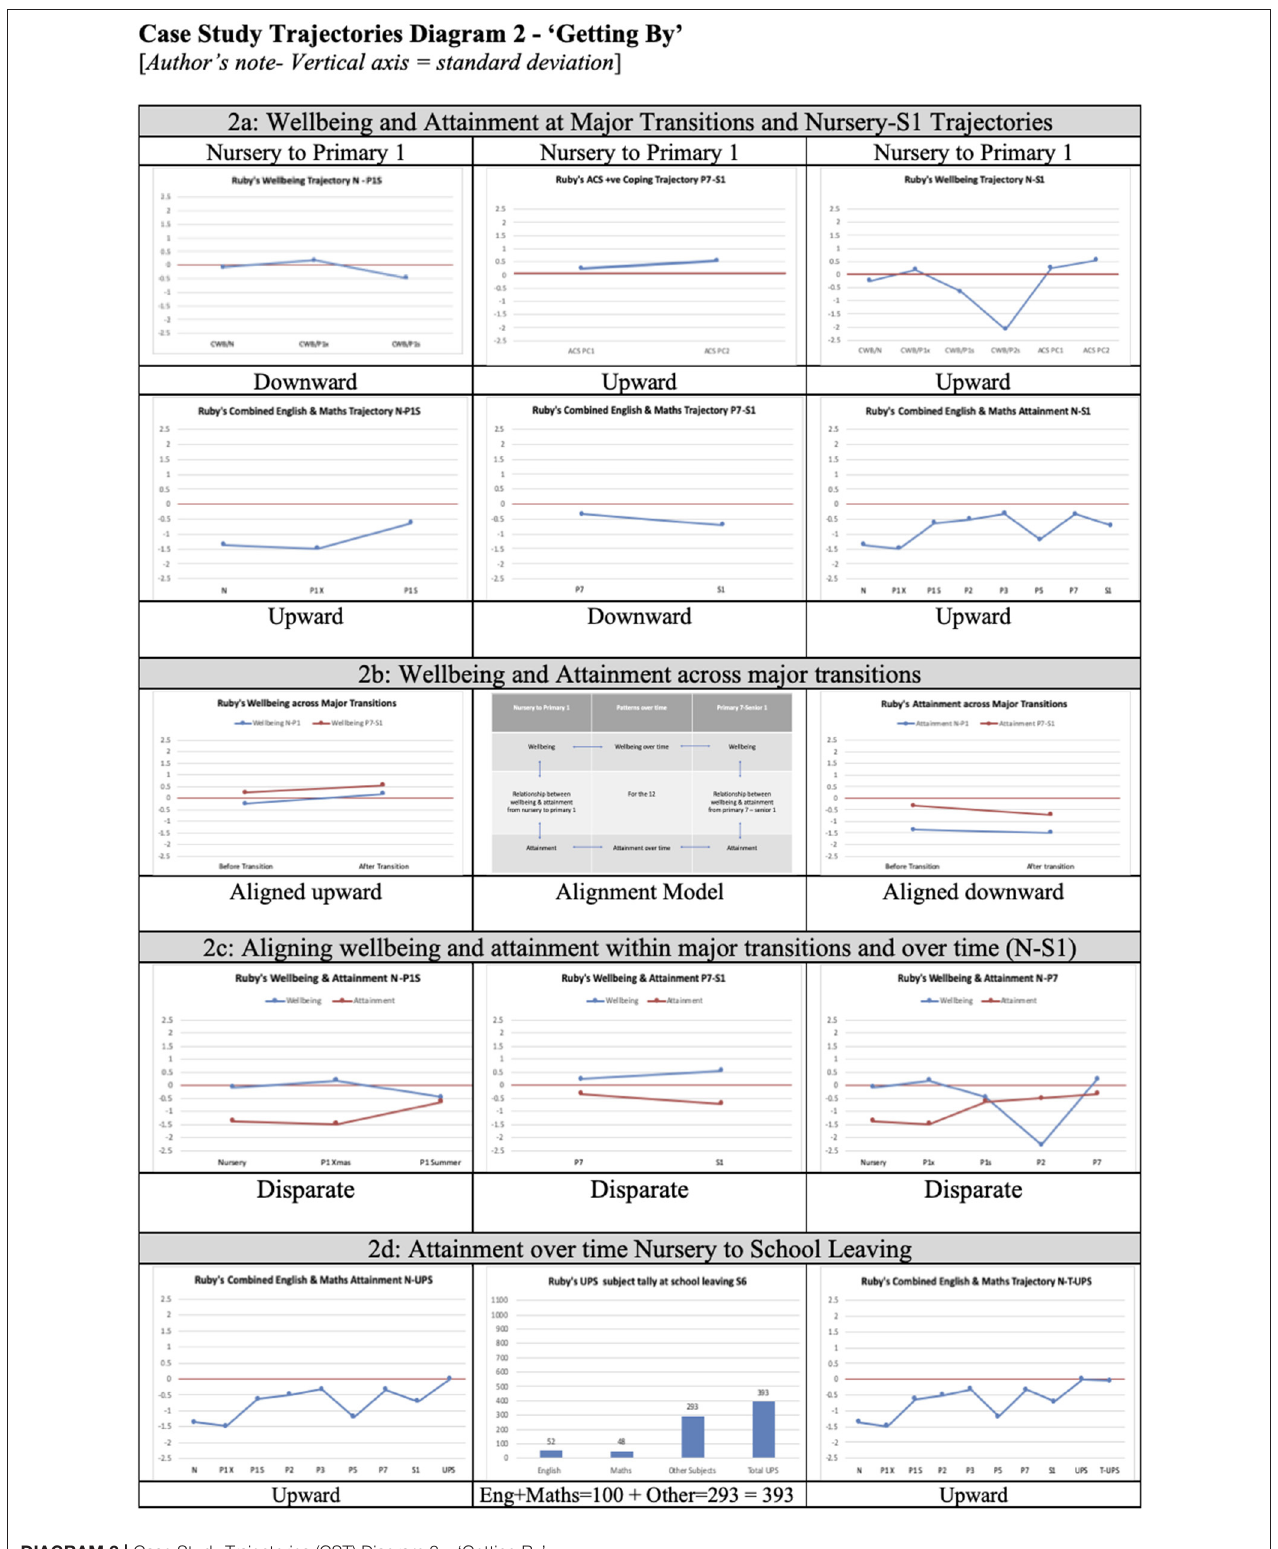
DIAGRAM 2 | Case Study Trajectories (CST) Diagram 2 – ‘Getting